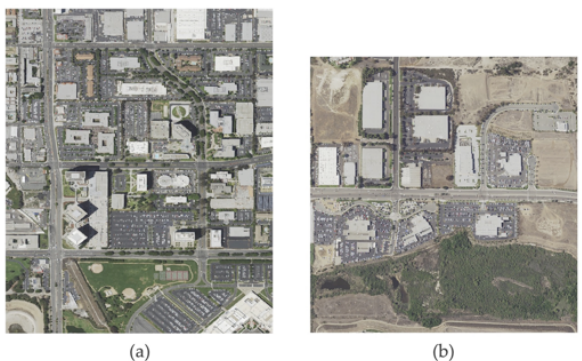
Figure 5. Experimental data. (a) Urban scene; (b) Suburban scene